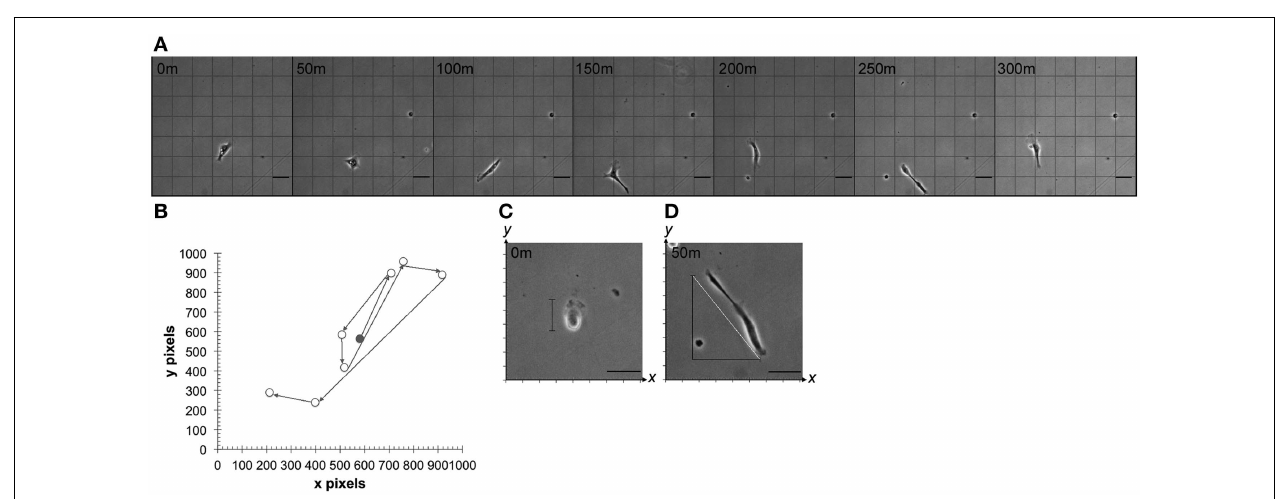
observed points when change of direction took place. Shaded circle represents nucleus at time 0. Cell expansion and contraction were measured by (C) calculating expanded cell diameter on x , y or (D) by calculating the hypotenuse of the triangle (white line) representative of expanded cell after obtaining x , y coordinates (m = minutes). Minutes represent elapsed time after first observation in vitro . Scale bar: 50 µ